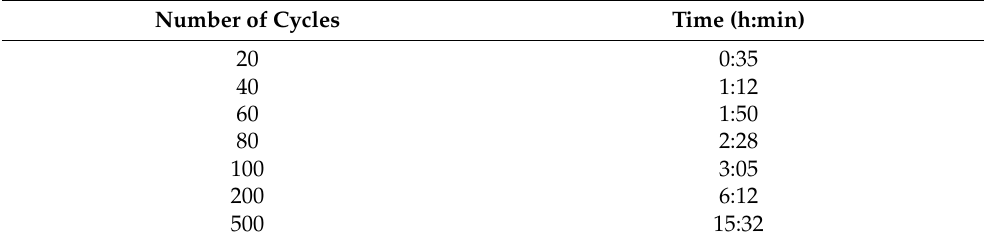
Table 6. Number of cycles and deposit time for films of a binary